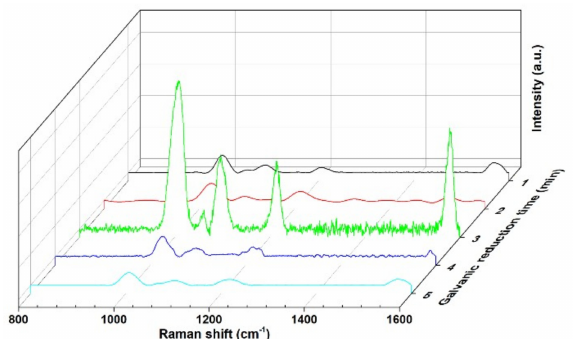
Figure 4. Surface-enhanced Raman scattering (SERS) spectra of 4-Mercaptopyridine (4-Mpy) absorbed on Au@Cu nanoarrays with galvanic reaction time ranging from 1 min to 5